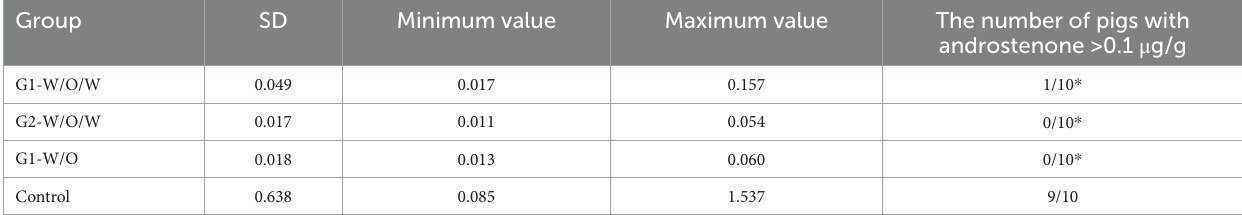
TABLE 5 Determined results of skatole in pig serum. Group The number of pigs with